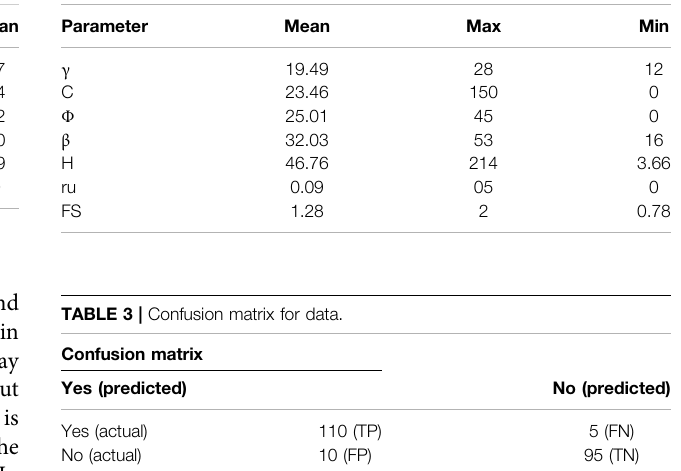
TABLE 1 | The descriptive statistical analysis of the classifcation data for model 1. TABLE 2 | The descriptive statistical analysis for model 2.